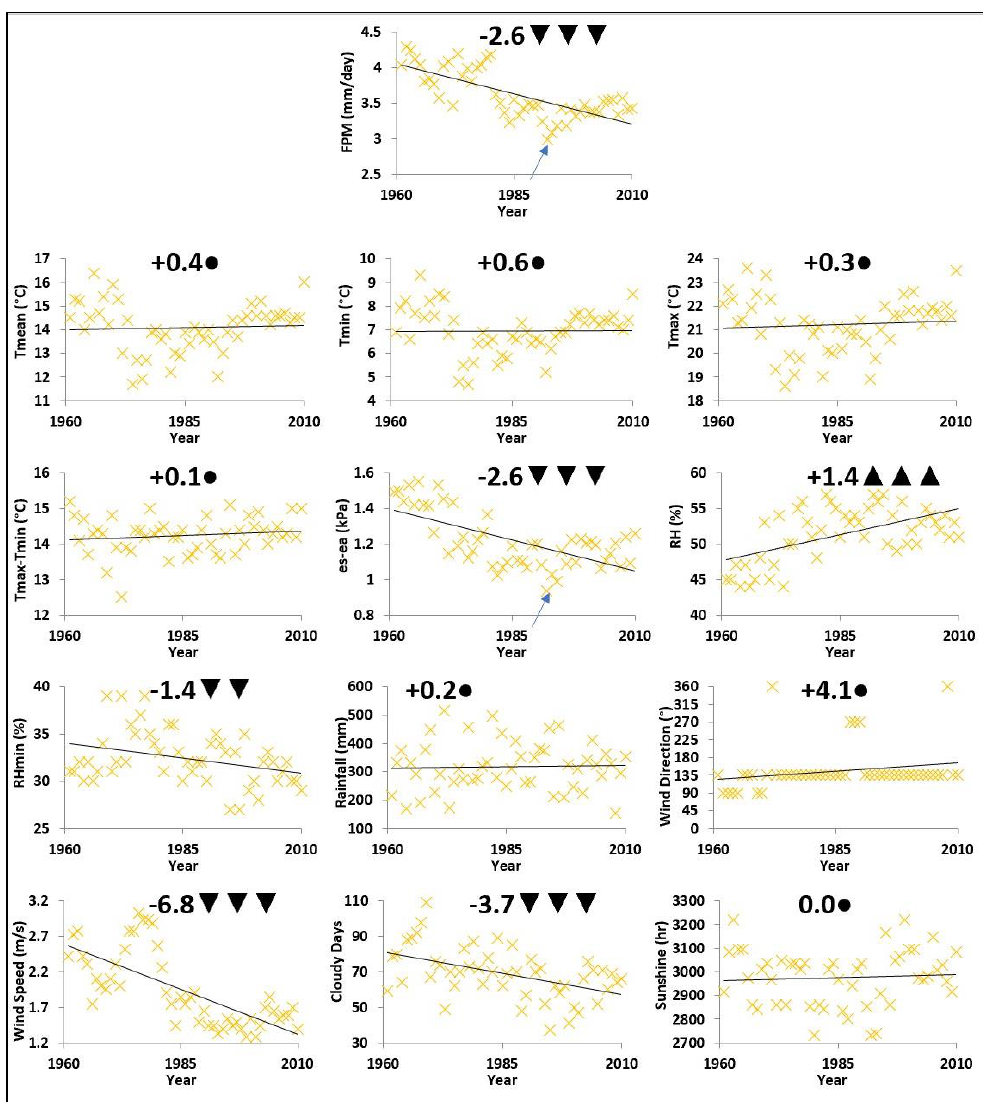
Figure 3. The 50-year (1960–2010) trends of annually averaged reference evapotranspiration and meteorological variables in Qazvin. Circles indicate an insignificant trend. One, two, and three triangles indicate a significant trend at a confidence level of 90%, 95%, and 99%, respectively. The value on the left of triangular symbols shows the increasing/decreasing rate over the 50-year period.